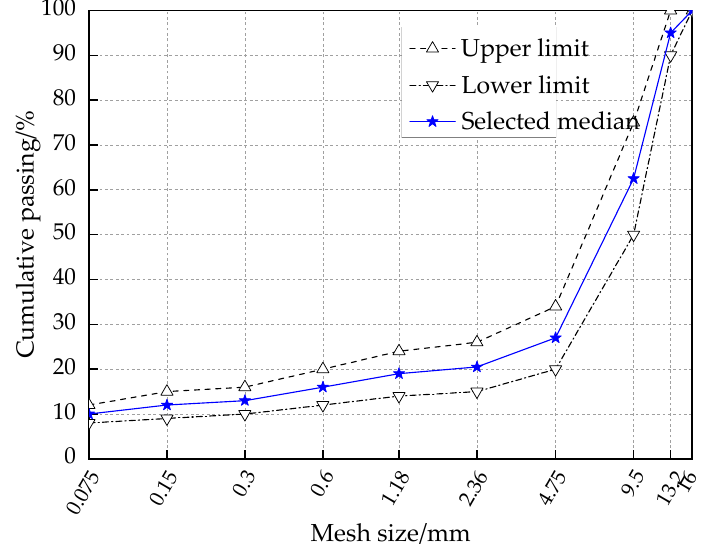
Figure 1. Gradation of SMA-13 in this study.